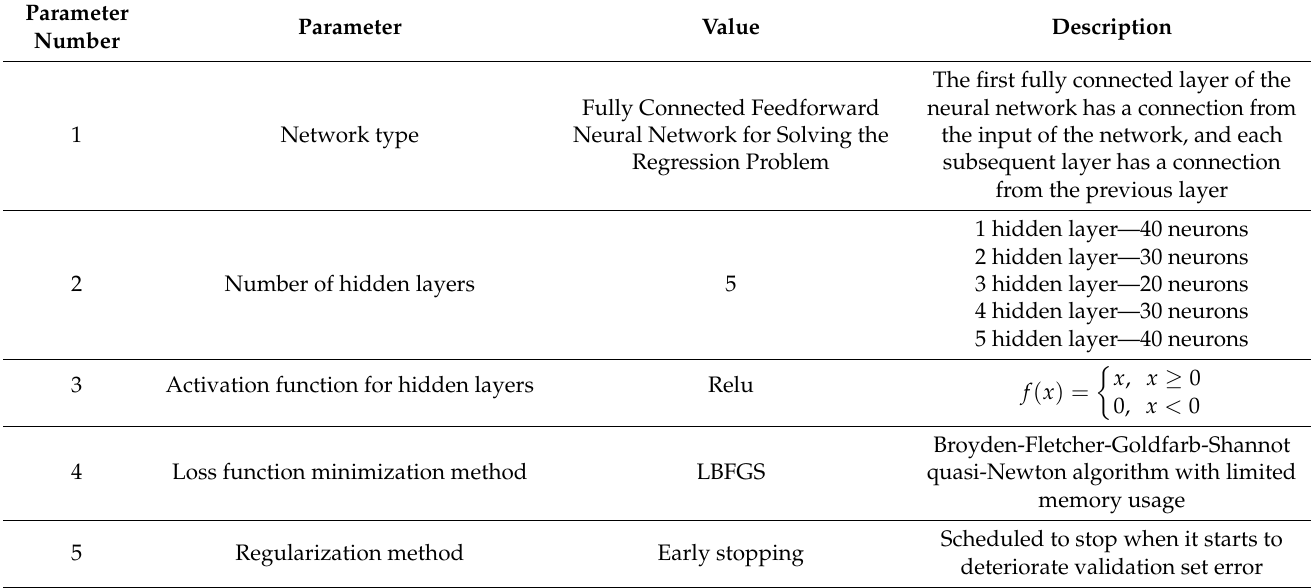
Table 3. Neural network